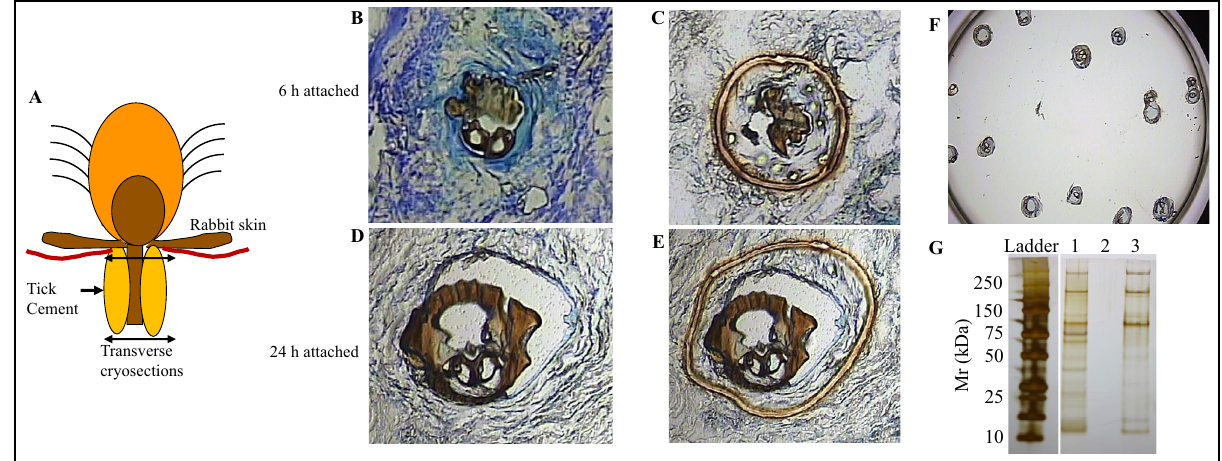
Figure 1. Microdissecting the inner core tick cement layer of Ixodes scapularis tick attachment cement. Adult female ticks were attached on rabbits for 6 and 24 h on rabbits. Skin punch biopsies of tick attachment sites were harvested using the 6 mm diameter biopsy puncher and placed into optimal cutting temperature compound (OCT), snap frozen on dry ice and stored at −80 °C until processed. Tick attachment biopsies were longitudinally cry sectioned ( A ), placed on PEN membrane slides and stained using the Arcturus HistoGene LCM Frozen Section Staining Kit. Tick attachment cement was located by position of mouthpart and lighter stain retention than adjacent skin tissue ( B,D ). Tick cement was dissected using the ultraviolet laser on Arcturus Pixcell II laser capture microscope ( C,E ). Dissected tick cement was recovered onto sample caps ( F ) and total proteins extracted overnight into 6 M urea buffer ( G ). Lanes 1 and 3 in ( G ) = protein extracts in cement of 6 and 24 h attached ticks, and lane 2 is an empty lane.